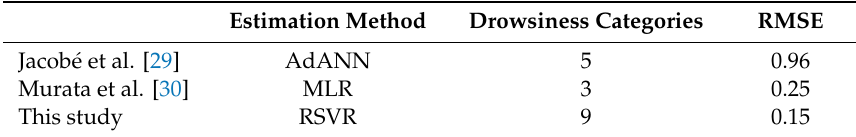
Table 3. Comparison of previous studies and the current study in drowsiness